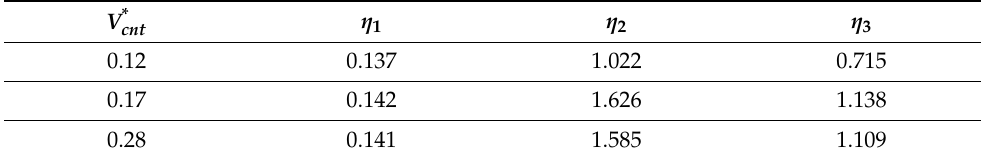
Table 1. CNT efficiency